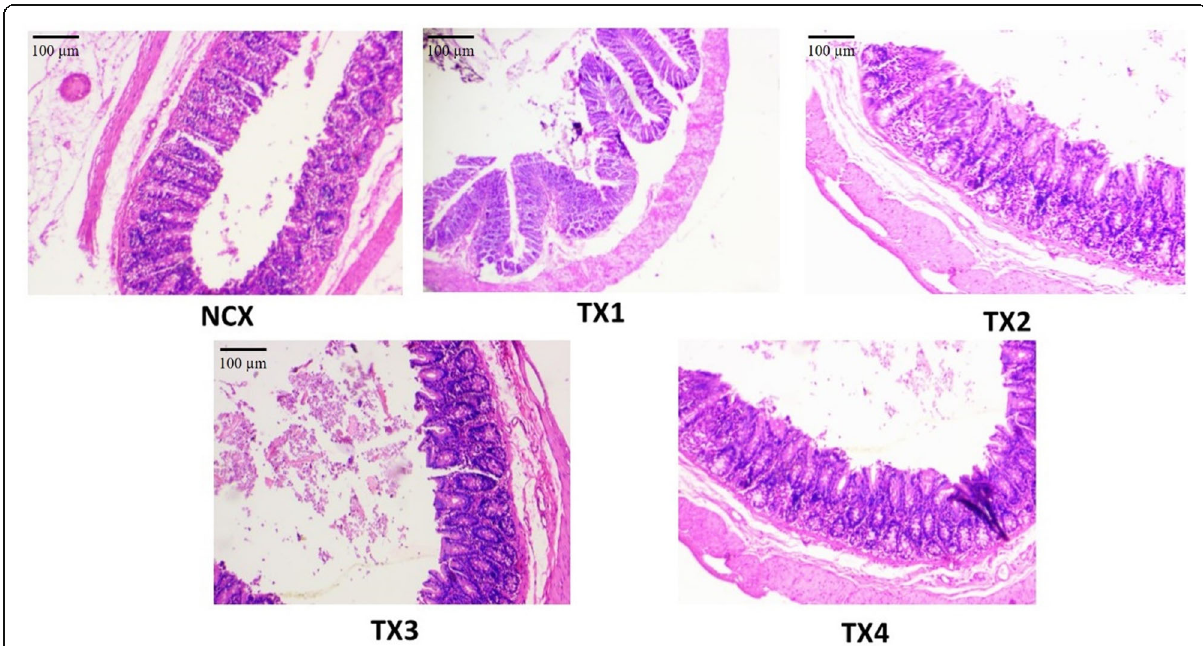
Fig. 7 The histopathology of stomach from the different group of swiss albino mice (40 × magnification; Scalar bar: 100 μ m). No significant damage (focal necrosis, mucus wall disruption, extensive congestion in mucosa and haemorrhagic bands) was observed in the inner lining of stomach of any treated groups rats. The inner mucus membrane was completly remained intact in all treatment group when compared to normal control group (NCX). Where NCX: Normal control group; TX1: Sub-acute toxicity group 1 (250 mg/kg/day/p.o); TX2: Sub-acute toxicity group 2 (500 mg/kg/day/p.o); TX3: Sub-acute toxicity group 3 (1000 mg/kg/day/p.o); TX4: Sub-acute toxicity group 4 (2000